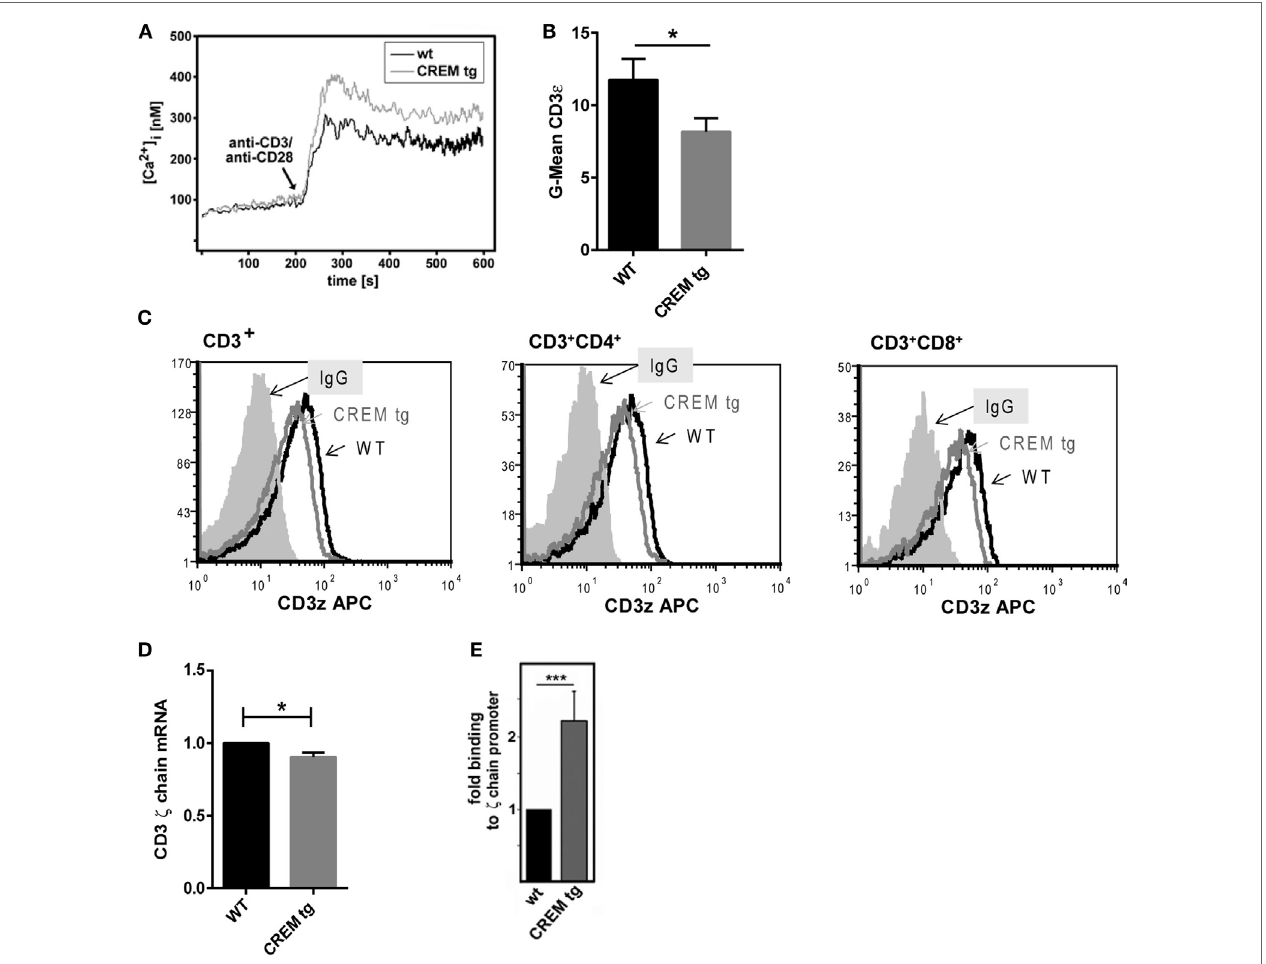
FigUre 2 | caMP-responsive element modulator alpha (creM α ) represses expression of cD3 ζ chain, which leads to enhanced calcium influx . (a) Pan-T cells were isolated via MACS isolation from CD2-CREM α TG mice and appropriate wild-type (WT) mice. Ca 2 + influx was measured immediately after stimulation with anti-CD3 and anti-CD28. The picture shows a typical experiment ( n = 4). (B) CD3 ζ chain expression was measured in CD3 + T cells of CREM α transgenic and WT mice by flow cytometry. (c) The picture shows a typical histogram of CD3 ζ chain expression in CD3 + (left), CD3 + CD4 + (middle), and CD3 + CD8 + T cells (right). (D) CD4 positive T cells were extracted by MACS isolation and mRNA expression of the CD3 ζ chain was determined ( n = 3, * p < 0.05). (e) Binding of CREM to the CD3 ζ promoter was determined by chromatin immunoprecipitation assay in unstimulated splenocytes of CREM α transgenic and WT mice ( n = 4, *** p <